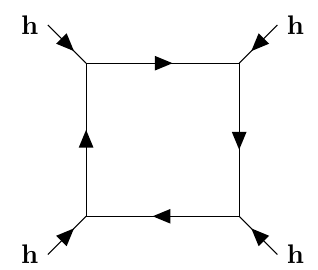
Figure 3 . This diagram fails to be BRST invariant in Poisson-BF